Question: In a single sentence, describe what this figure presents.
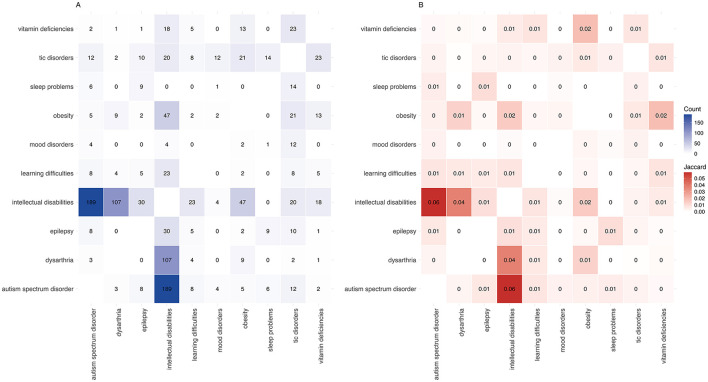
Answer: Co-occurrence of 10 chronic diseases or health problems. (A) Frequency of occurrence. (B) Jaccard similarity coefficients.